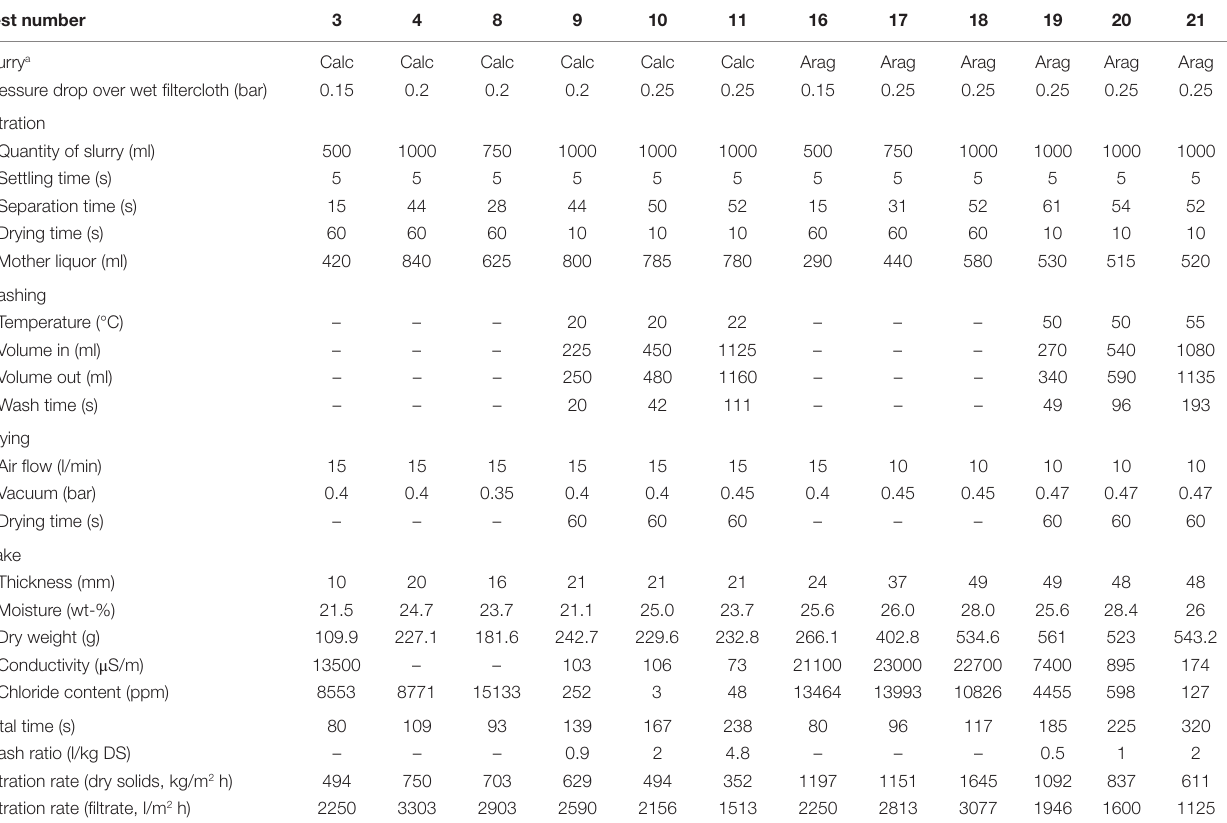
TaBle 6 | Parameters used in the vacuum filtration